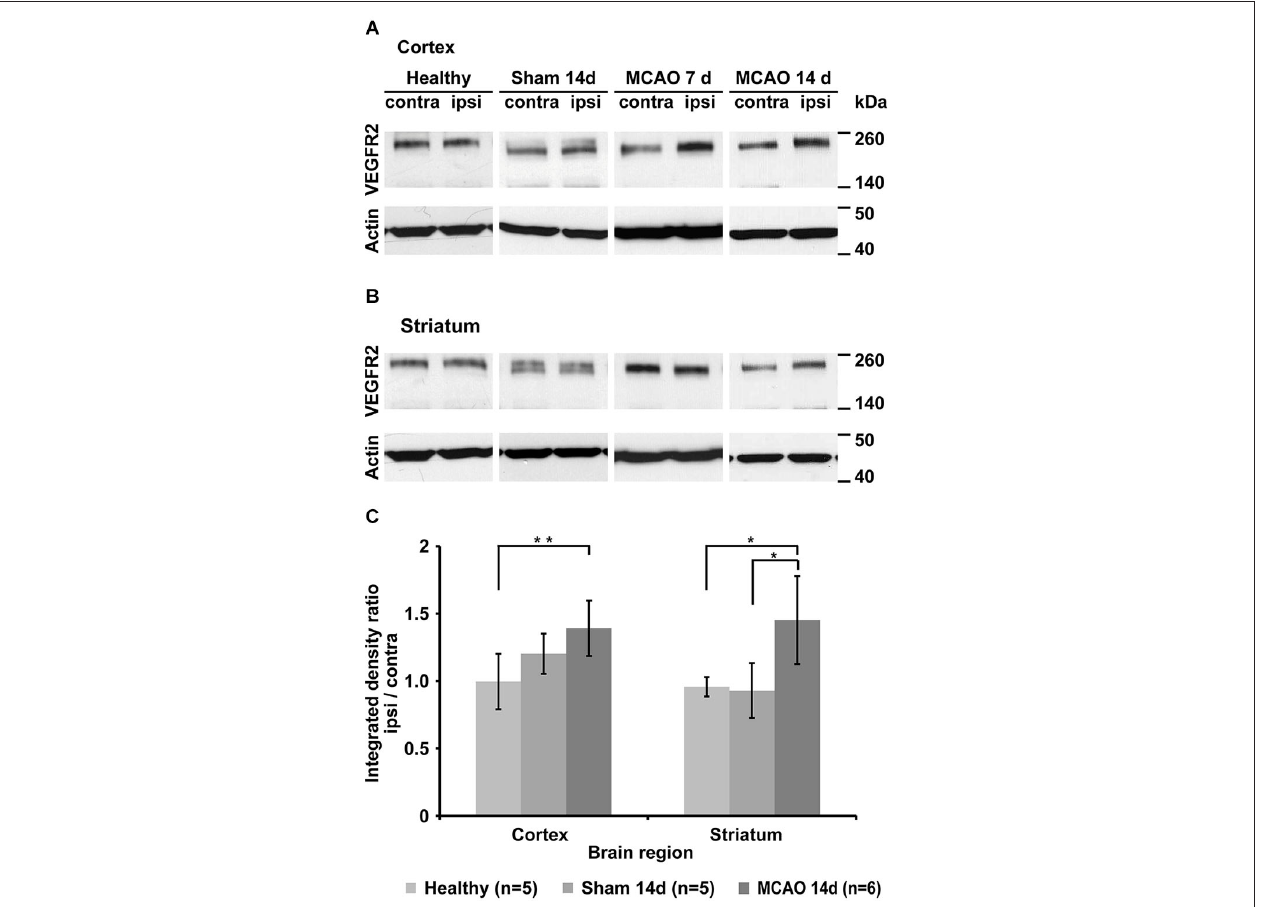
FIGURE 4 | Qualitative and quantitative evaluation of tissue VEGFR2 protein content. (A) Representative Western blots from cortical tissue samples for each group showing increased VEGFR2 (210 and 230 kDa) content in the ischemic cortex of animals that underwent MCAO. Note the strong increase in the 7d group. Sham animals and healthy control display similar levels between left and right hemisphere. (B)